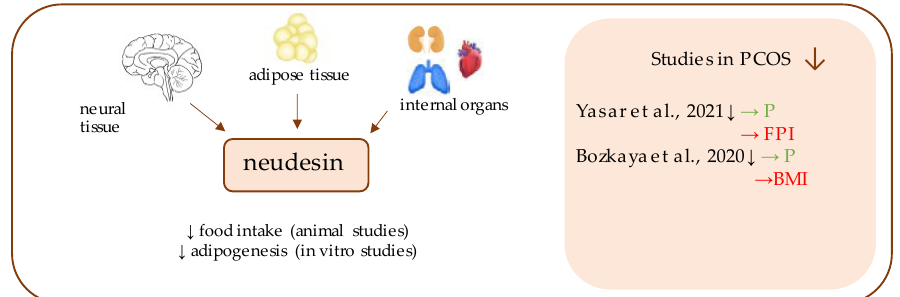
Figure 10. Role of neudesin in the pathogenesis of insulin resistance and PCOS. List of the studies assessing neudesin in serum of the patients with PCOS. ↓ indicates that concentration level of neudesin was decreased in PCOS individuals ( p < 0.05); → (green)—indicates positive correlation between serum neudesin and particular indicators; → (red)—indicates negative correlation between serum neudesin and particular indicator; P—progesterone; FPI—fasting plasma insulin; BMI—body mass index.